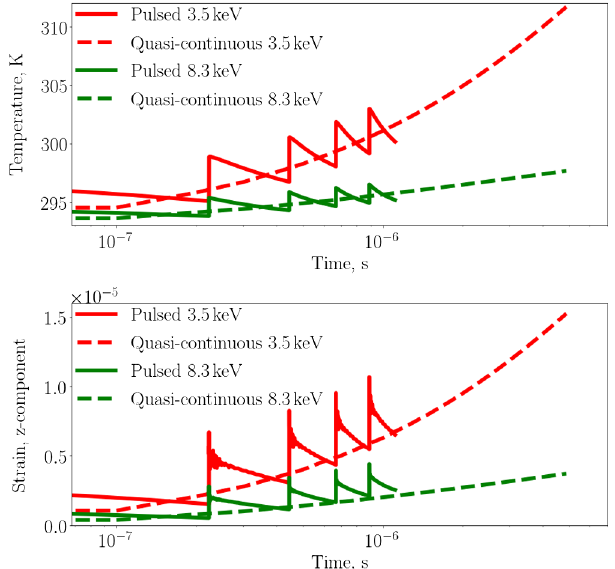
FIG. 7. Calculations of peak temperatures and strains as in Fig. 6 using impulsive heating model treating each pulse in the train individually. Dashed lines correspond to the quasicontin- uous